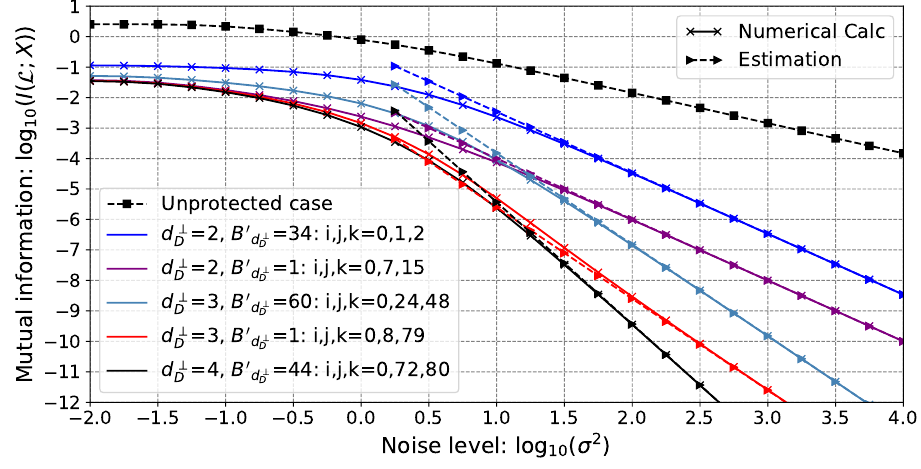
Figure 2: Numerical calculation and approximation of I [ L ; X ] between leakage L and the sensitive variable X in (3 , 1)-SSS based masking. The three public points are α α i , α 2 = α j , α 3 = α k